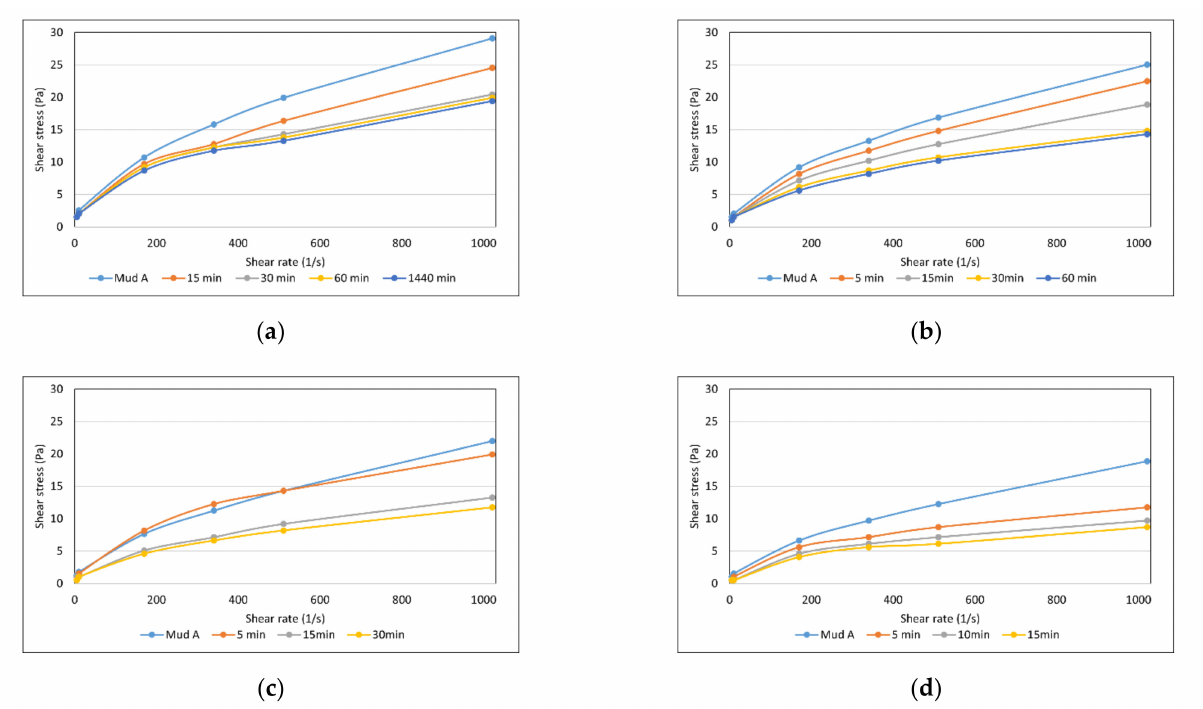
Figure 1. Flow curves of drilling mud A with 1.0% calcium hypochlorite: ( a ) at a temperature of 20 ◦ C, ( b ) at a temperature